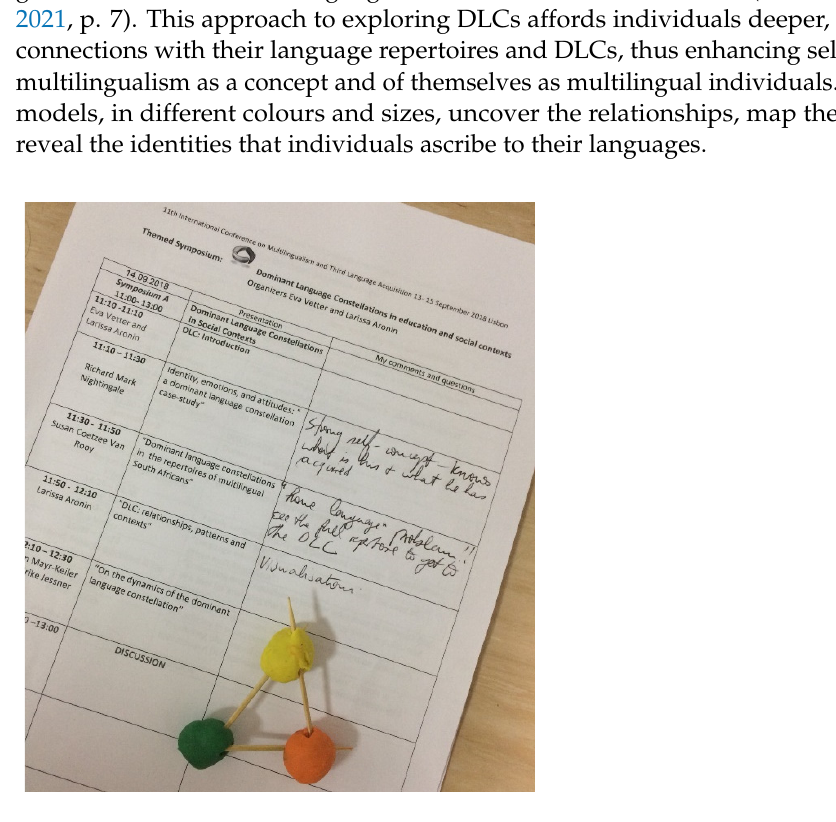
Figure 1. Author’s DLC model created at the XIth International Conference on Third Language Acquisition Multilingualism in Lisbon (Aronin 2018) and reproduced in Aronin (2021). Visualization methods, such as DLC maps, plasticine models, and computer-assisted